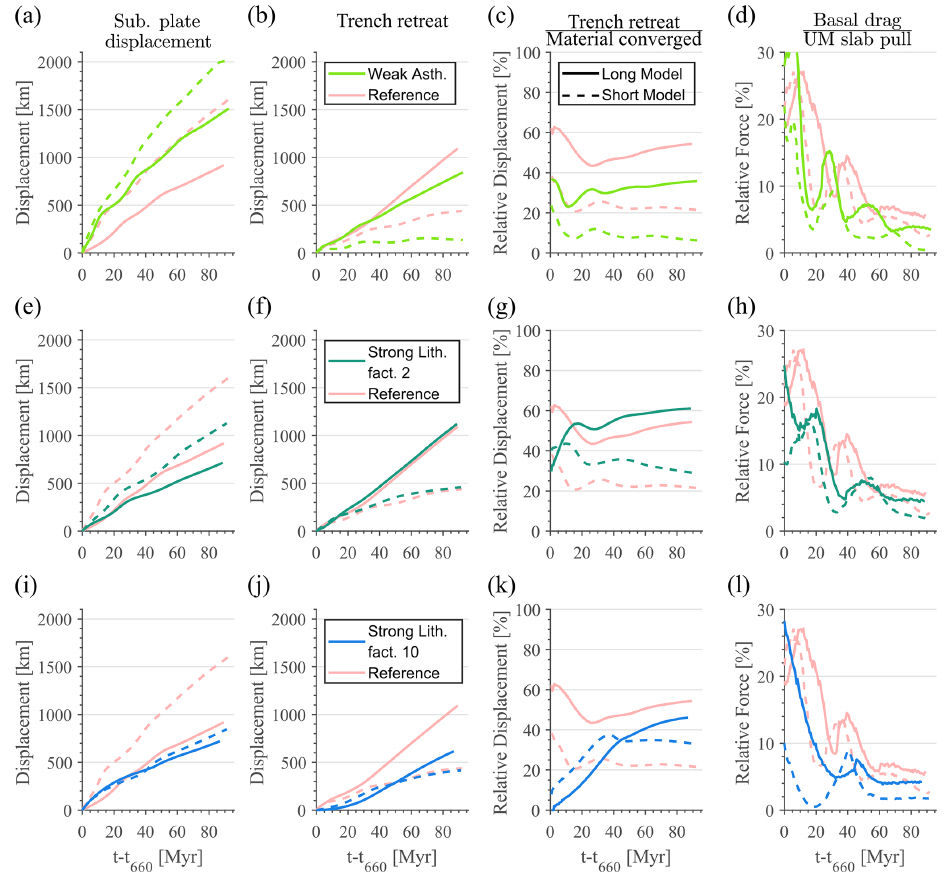
Figure 6. Temporal evolution of the long-plate (full lines) and short-plate (dashed lines) models. Rows of graphs are for different types of models, where (a) – (d) are weak asthenosphere models, (e) – (h) are strong lithosphere (factor 2) models and (i) – (l) are strong lithosphere (factor 10) models. The first column, (a) , (e) and (i) , shows the displacement of the subducting plate from the initial state, the second column, (b) , (f) , and (j) , the amount of trench retreat, the third column, (c) , (g) and (k) , shows trench retreat significance as percentage of the total material converged, and the fourth column, (d) , (h) and (l) , shows the ratio of basal drag to upper-mantle slab pull force. All models are compared with the reference models, shown in light